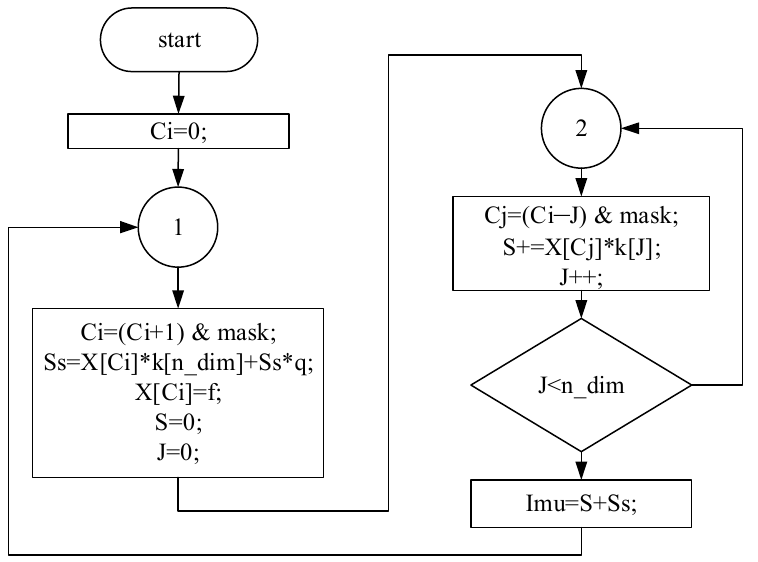
Figure 2. Algorithm for calculating the fractional integral.